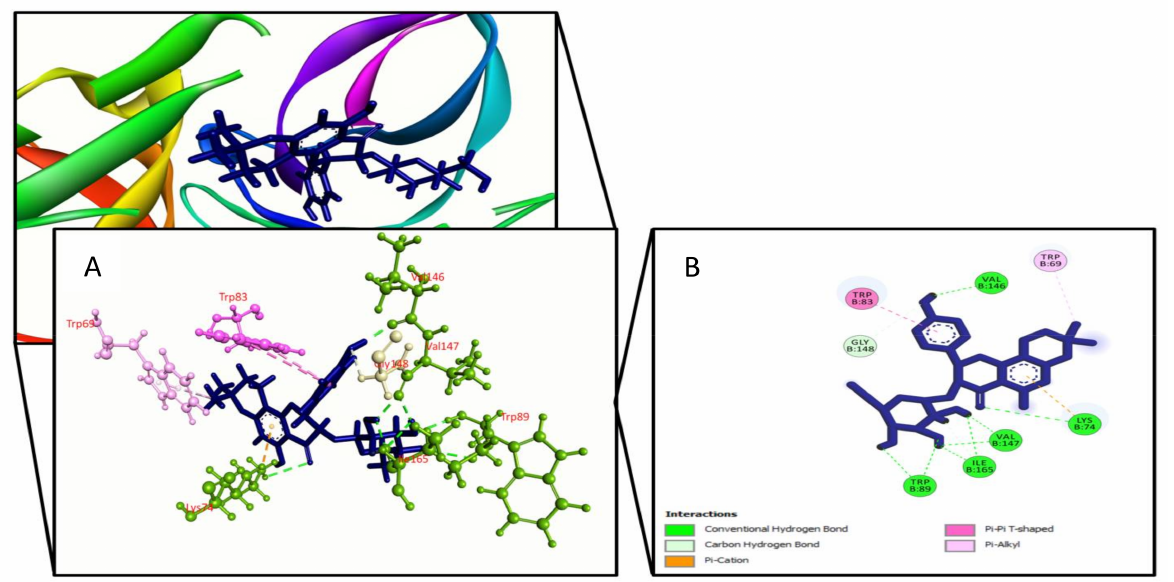
Figure 2. Phellodendroside binding the Dengue virus NS2B/NS3 protease (PDB: 2FOM), ( A ) 3D representation and ( B ) 2D representation. Hydrogen bonds are displayed as green ball and stick, hydrophobic bonds (Pi–Pi/Pi–sigma/amide–Pi interactions) are displayed as deep pink ball and stick, hydrophobic bonds (Pi–alkyl/alkyl interactions) are displayed as light pink ball and stick, carbon–hydrogen bonds are displayed as white ball and